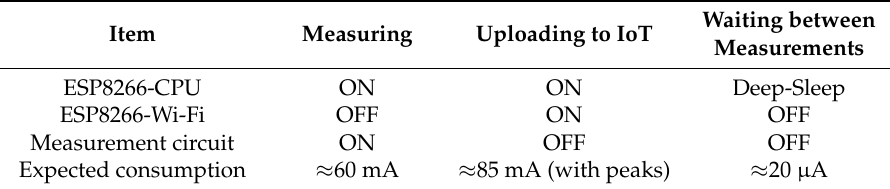
Table 2. Summary of the elements activated at each time.